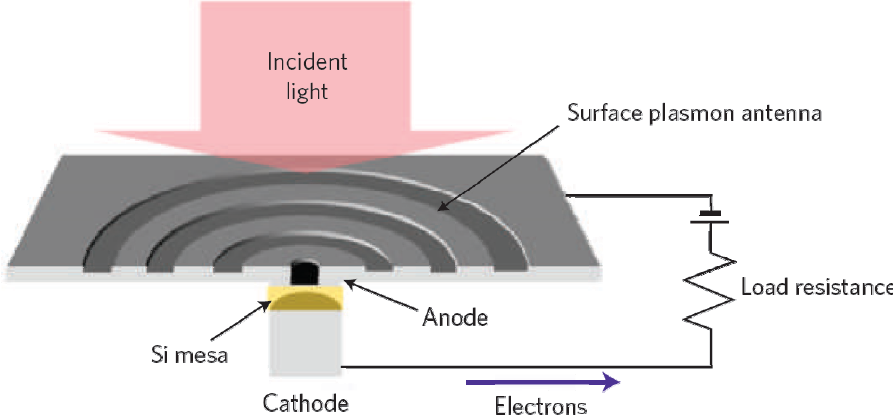
Figure 13. Concentric grating coupler used in the nano-photodiode. From